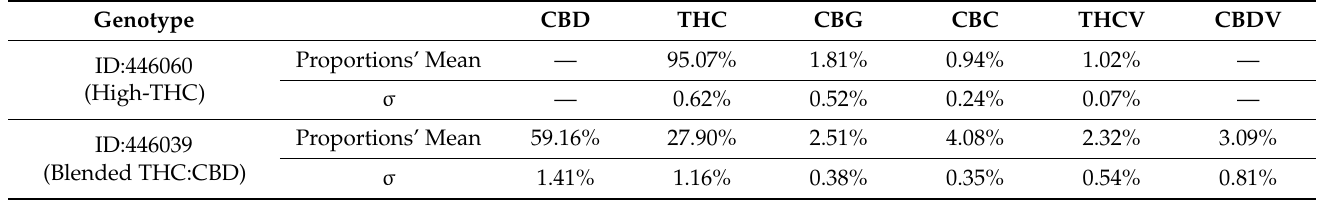
Table 3. The stability of the ratios between cannabinoid quantities (% of the overall TCC). Genotypes 446060 and 446039 correspond with those presented in Figure 6A and 6B,respectively. The presented THC quantity also comprises the produced CBN. Cannabidiol (CBD) and ∆ 9 -tetrahydrocannabinol (THC) values include both the acidic and decarboxylated molecule forms. All cannabinoid transfor- mations and amalgamates were performed through molecular weight conversion. The depicted σ represents a sample standard deviation